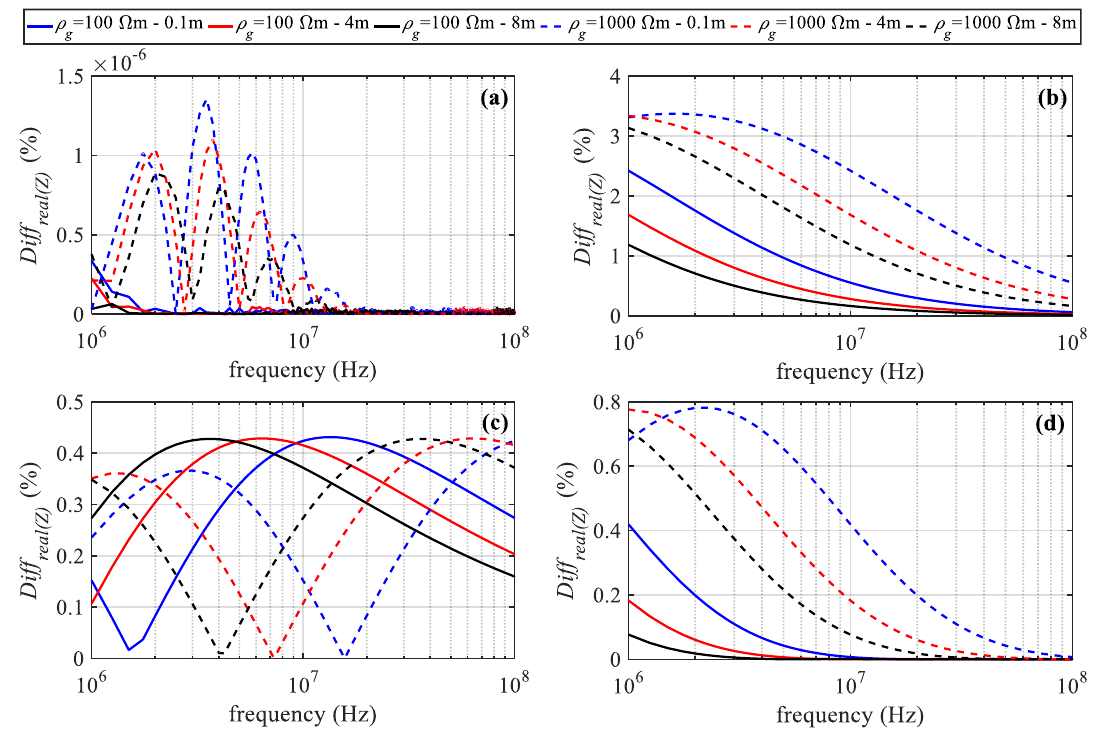
Figure 15. Differences in the real part of Z 13 in NB using the closed-form expression of ( a ) Carson, ( b ) Dubanton ( c ) Noda and ( d ) Alvarado-Betancourt.